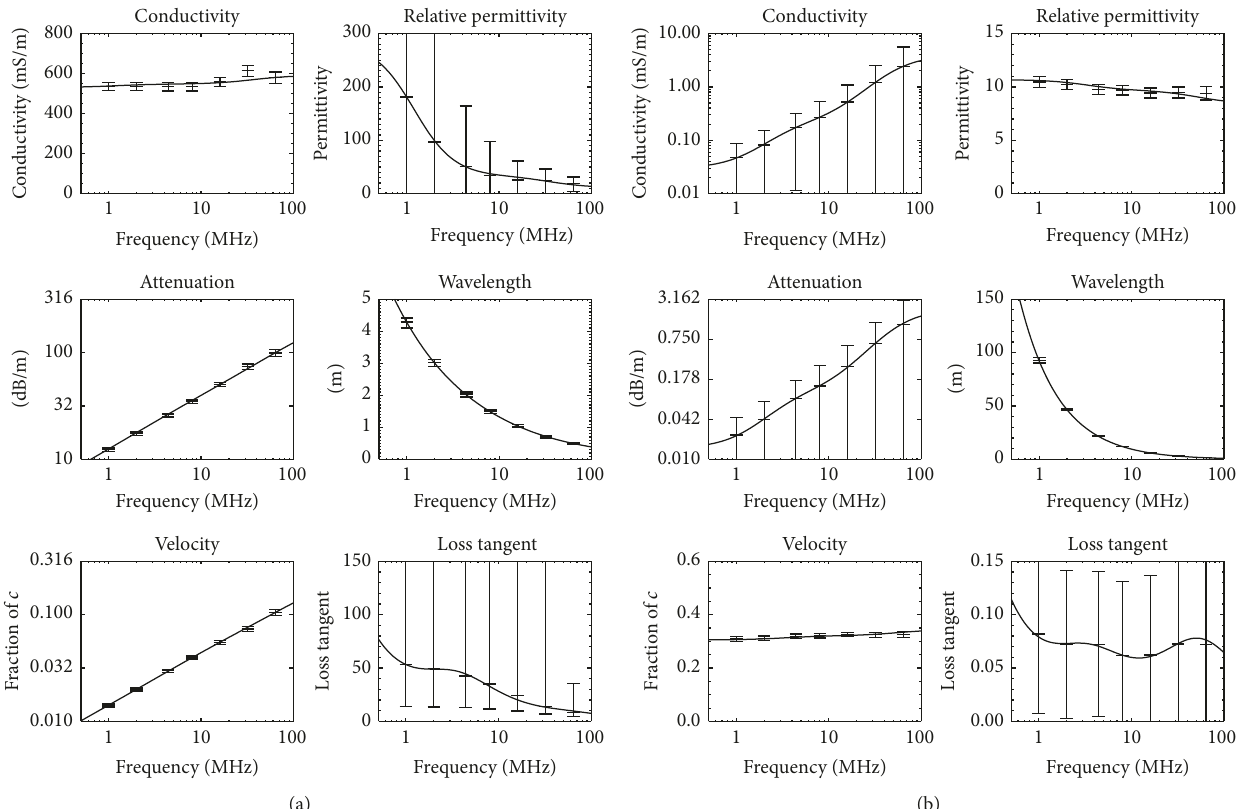
Figure 4: The electrical properties of a sulphide sample (a) and a granite sample (b) from Vogt